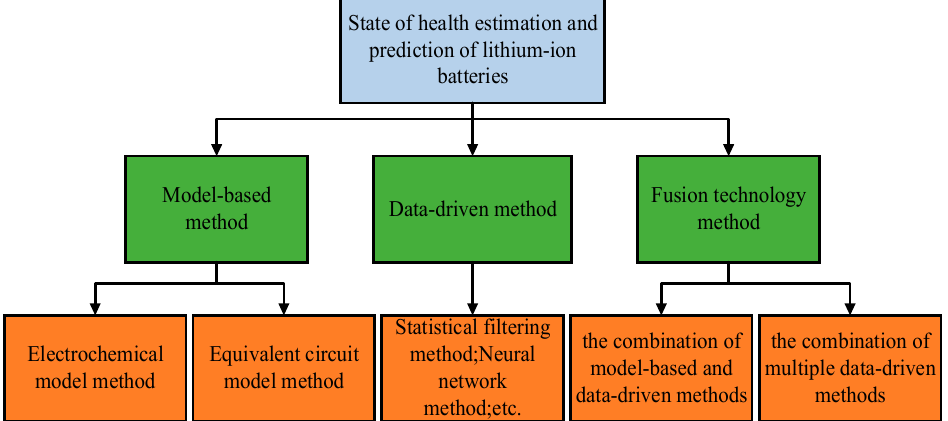
Figure 2. Algorithm classification structure.